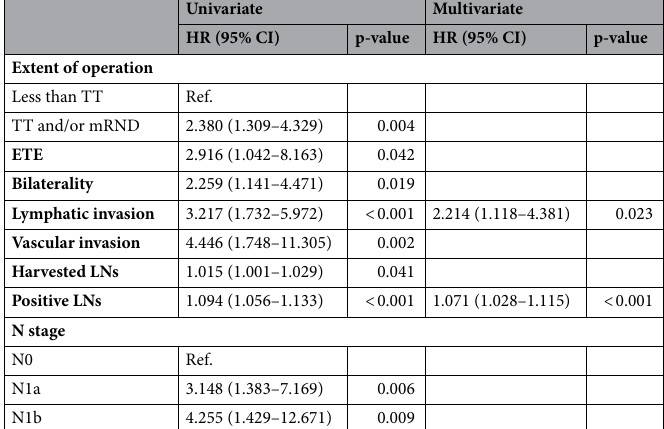
Table 5. Univariate and multivariate analyses of risk factors for recurrence in patients aged 20–45 years after propensity score matching. Data are expressed as hazard ratio (HR) and 95% confidence interval (CI). A p value < 0.05 was considered statistically significant. TT total thyroidectomy, mRND modified radical neck dissection, ETE extrathyroidal extension, LN lymph node, N